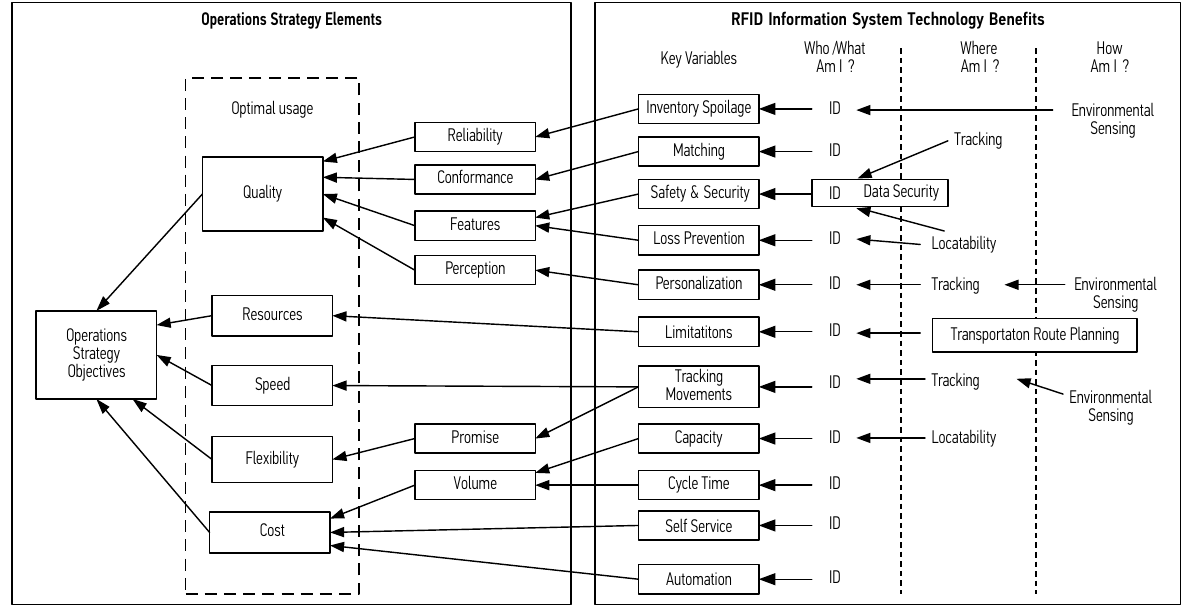
Fig. 1. A strategy framework for intermodal container transportation operations and RFID benefits